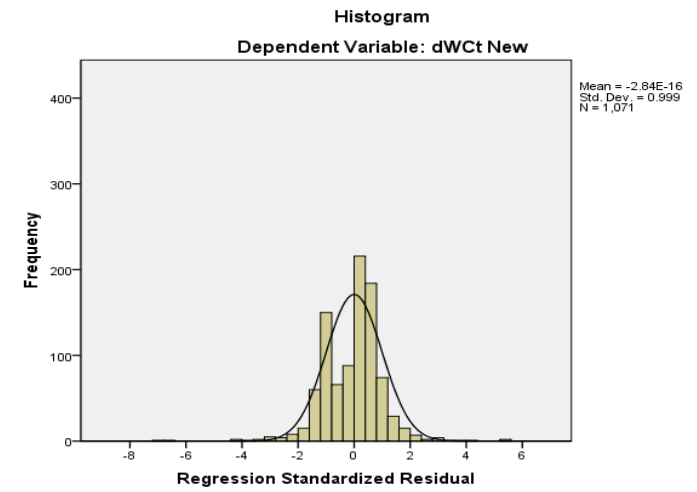
Fig. 1. Regression Standardized